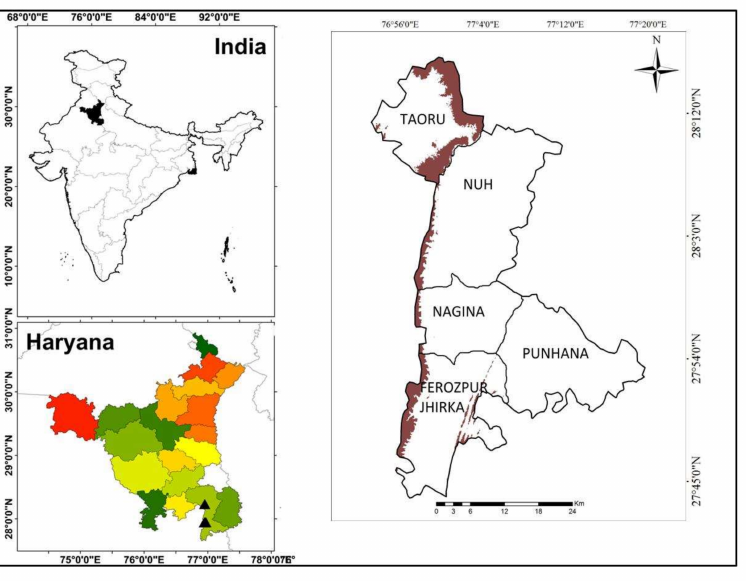
Figure 1. Location map of the study area depicting the district boundaries with Aravalli